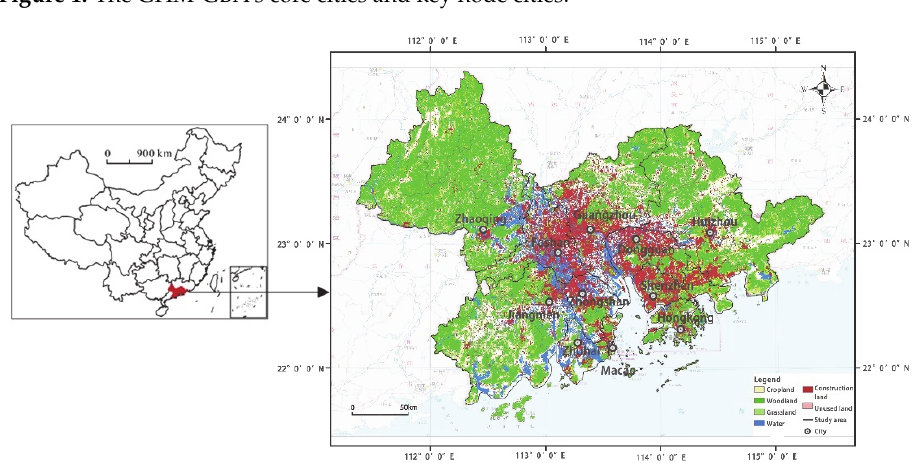
Figure 2. Location of the GHM-GBA.